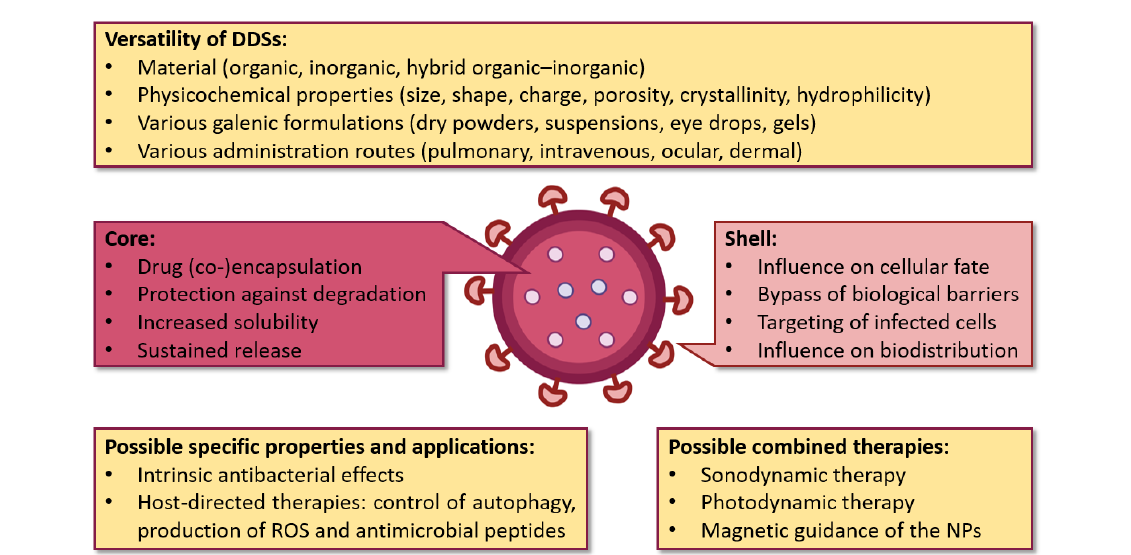
Figure 16. Schematic summary of the advantages and properties of nanosized drug delivery systems (DDSs) for the treatment of tuberculosis. Drug-loaded nanoparticles (NPs) can be administered by various routes, and their surface can be engineered with functional coatings. They can also be endowed with intrinsic antibacterial effects. Possible applications are in the field of host-directed or combined therapies. ROS: reactive oxygen species. Created with BioRender.com.